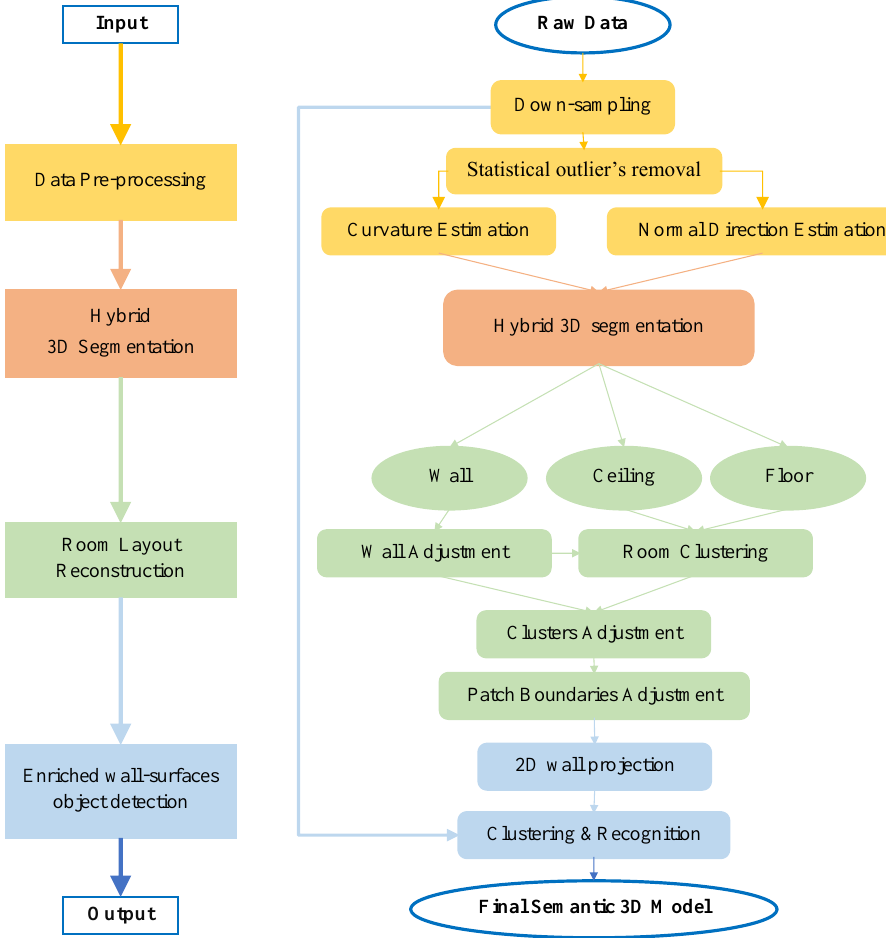
Figure 1. The overall process of the proposed method (different colors refer to different stages).